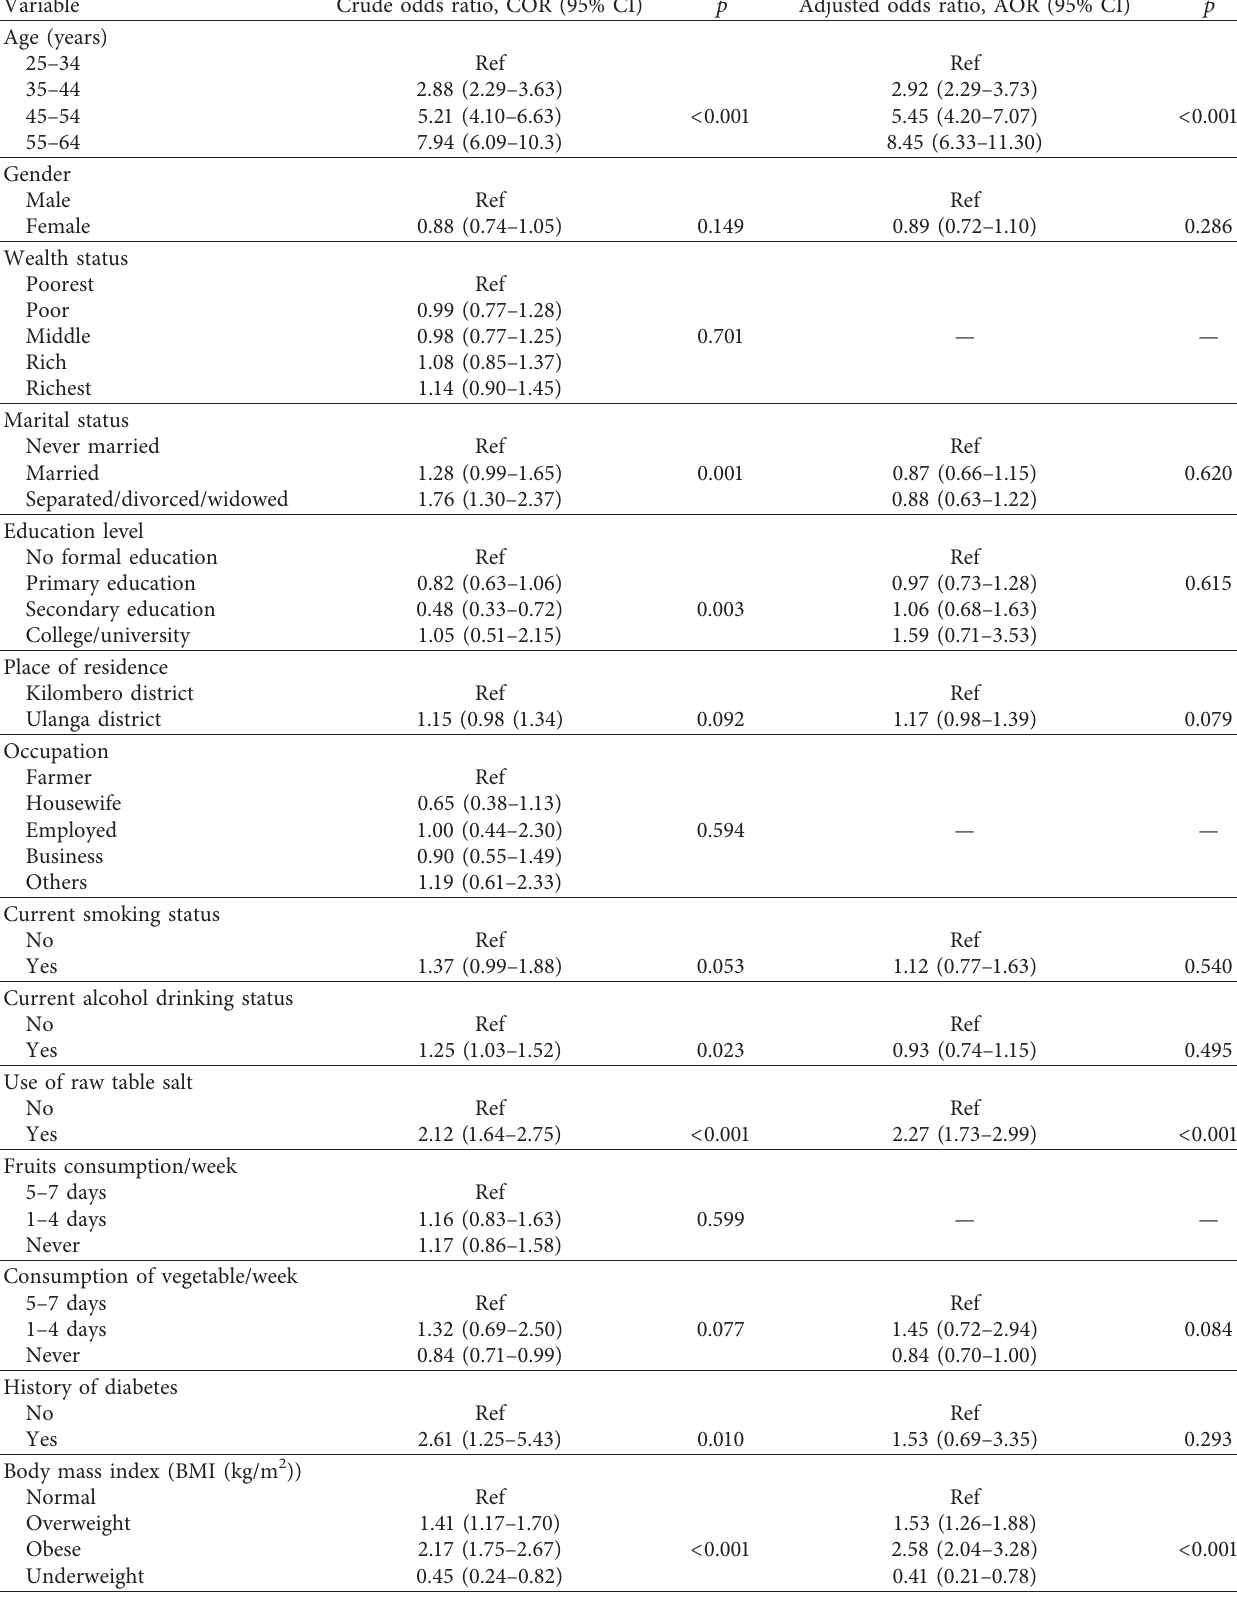
Table 3: Crude and multivariate adjusted logistic regression models for determinants of hypertension in the study population ( N � 3000).